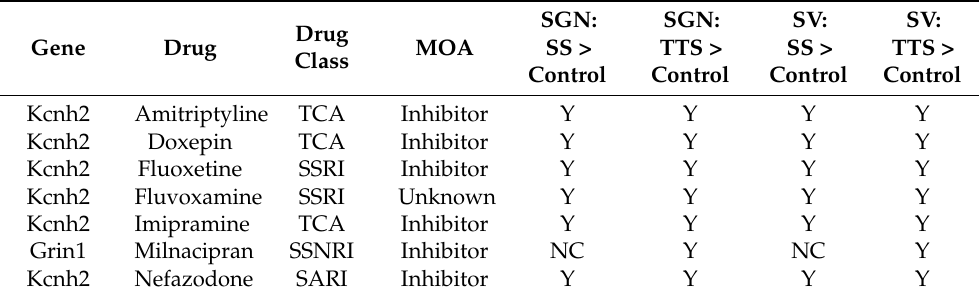
Table 1. FDA approved, orally administered antidepressants that interact with steroid-responsive genes in the cochlea localized to SGN and SV cell types.